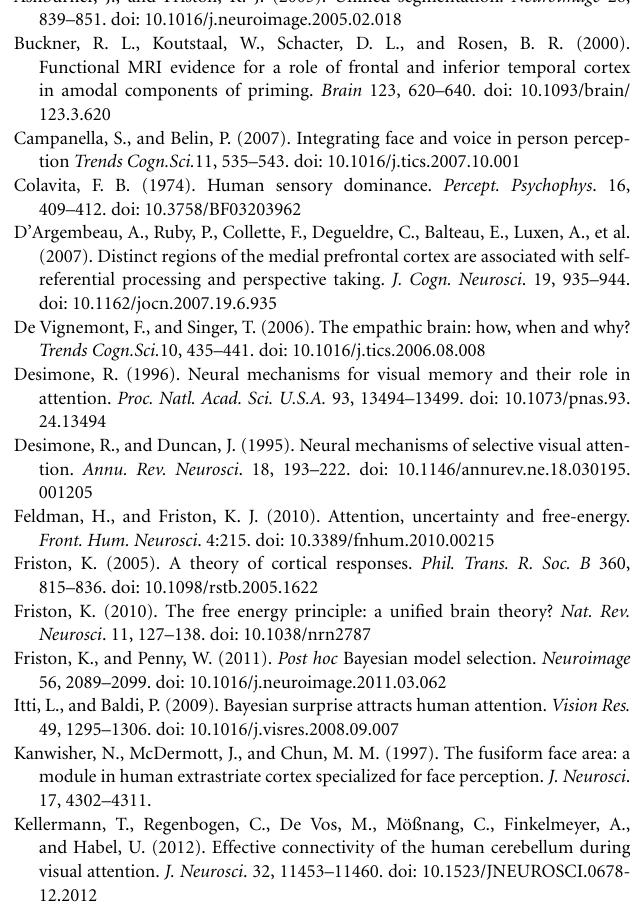
Table S1 | Post-hoc comparisons for each repeated measures ANOVA for the regions of